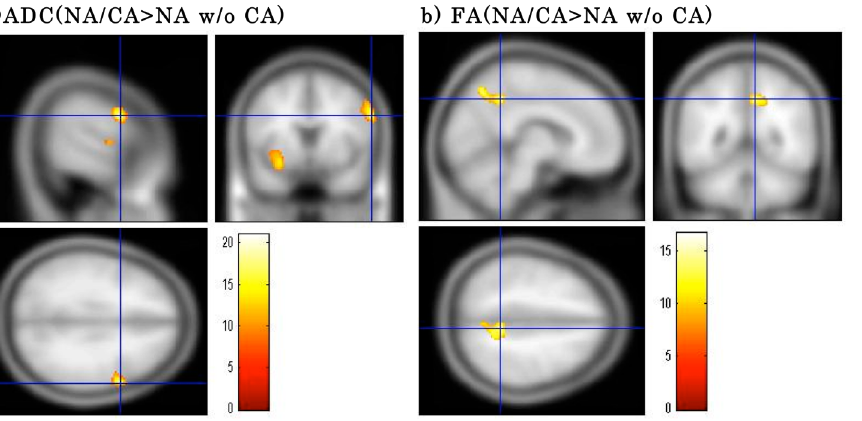
Figure 2. Clusters showing significant main effects of group on ADC and FA values between the narcolepsy with cataplexy (NA/CA) and narcolepsy without cataplexy (NA w/o CA) groups. a) ADC value was higher in the right inferior frontal gyrus (Brodmann area 9) for the NA/CA group than for the NA w/o CA group. b) In the NA/CA group, the FA value in the right parietal lobe (precuneus) was higher than that in the NA w/o CAgroup. Results are significant at FWE-corrected p , 0.05. Color scale is for F statistic.